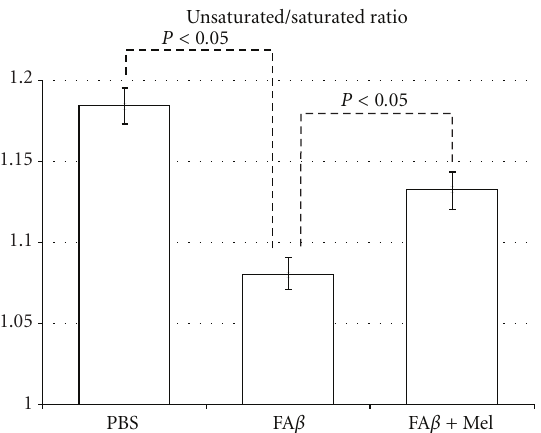
Figure 5: fA β -injected brains decreased significantly the U/S ratio, as compared with the PBS-injected brains. However, brains of animals taking oral melatonin showed a U/S ratio closer to the control